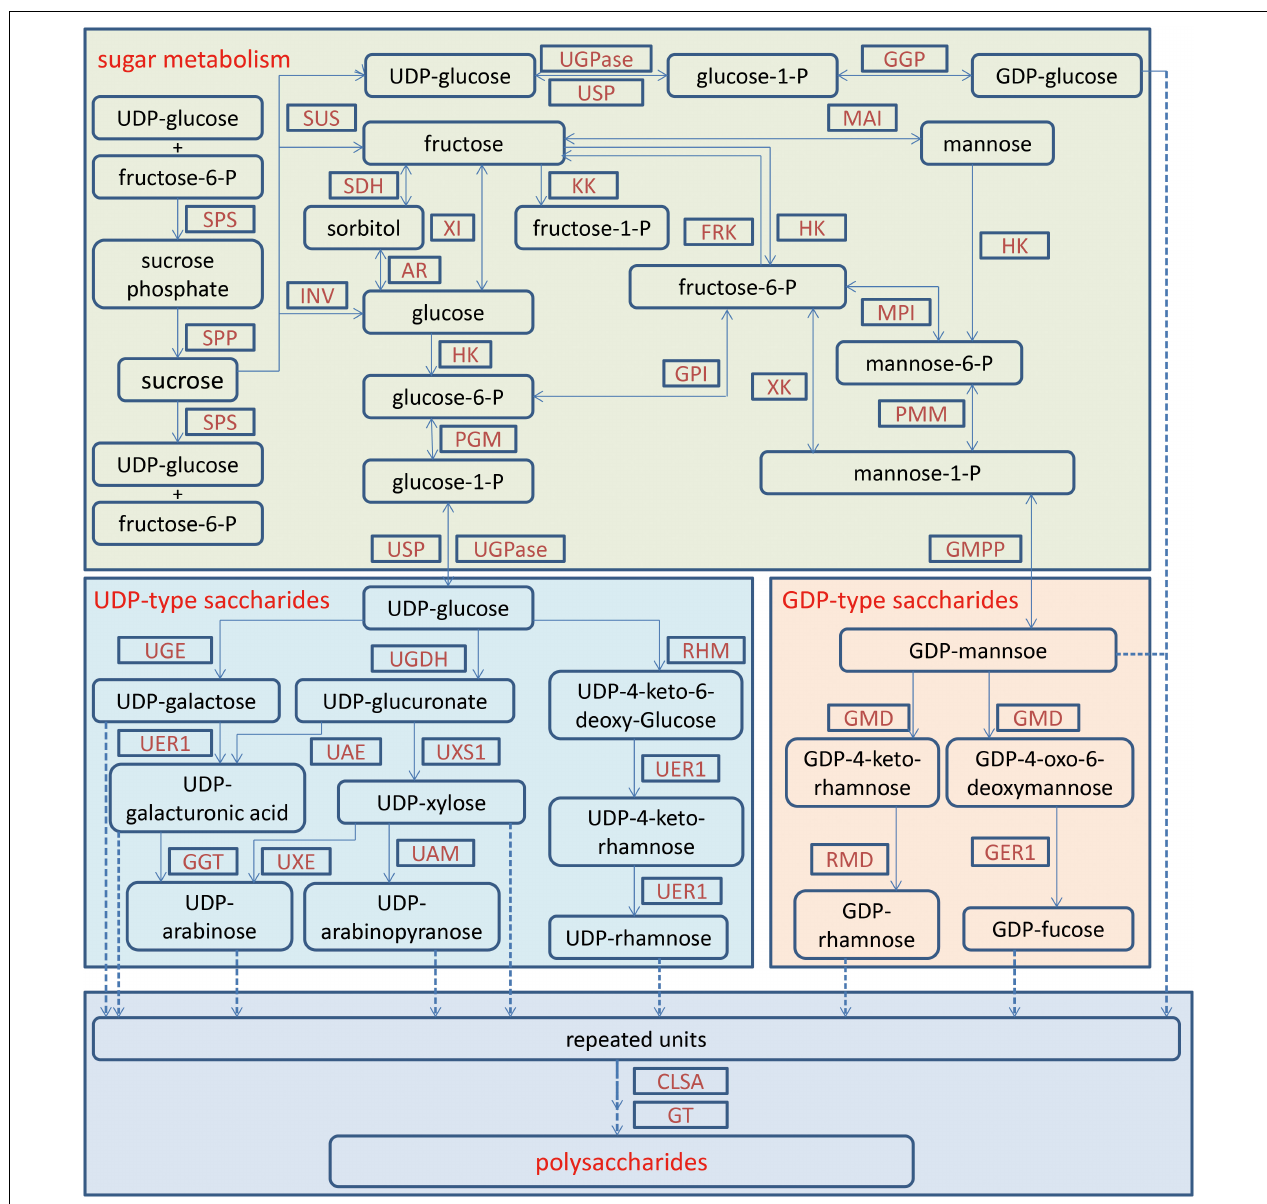
FIGURE 2 | The biosynthetic pathway for polysaccharides in Dendrobium officinale . The biosynthesis of polysaccharides contains sugar metabolism, UDP-saccharide metabolism, GDP-saccharide metabolism and polysaccharide formation. AR, aldose reductase; CSLA, cellulose synthase-like A; FRK, fructokinase; GAE, UDP-glucose A-4-epimerase; GER1, GDP-4-keto-6-deoxy-D-mannose-3,5-epimerase-4-reductase; GGP, glucose-1-phosphate guanylyltransferase; GGT, UDP-galacturonate decarboxylase; GMD, GDP-D-mannose-4,6-dehydratase; GMPP, mannose-1-phosphate guanylyl transferase; GPI, glucose-6-phosphate isomerase; GT, glycosyltransferases; HK, hexokinase; INV, invertase; KK, ketohexokinase; MAI, mannose isomerase; MPI, mannose-6-phosphate isomerase; PGM, phosphoglucomutase; PMM, phosphomannomutase; RHM, UDP-glucose 4, 6-dehydratase; RMD, GDP-4-dehydro-D-rhamnose reductase; SDH, sorbitol dehydrogenase; SPP, sucrose phosphate phosphatase; SPS, sucrose phosphate synthase; SuS, sucrose synthase; TSTA3, GDP-l-fucose synthase; UAE, UDP-glucuronate 4-epimerase; UAM, UDP-arabinopyranose mutase; UER1, 3,5-epimerase/4-reductase; UGDH, UDP-glucose dehydrogenase; UGE, UDP-glucuronate 4-epimerase; UGPase, UDP-glucose pyrophosphorylase; USP, UDP-sugar pyrophosphorylase; UXE, UDP-arabinose 4-epimerase; UXS1, UDP-glucuronate decarboxylase; XI, xylose isomerase; XK,